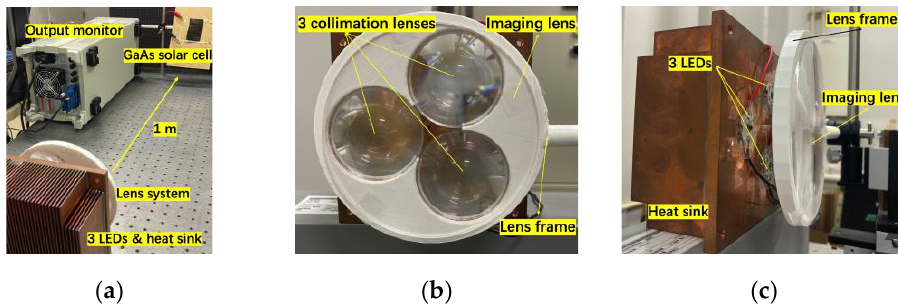
Figure 7. ( a ) Experiment setup; ( b ) lens combination; and ( c ) view from the side of the light source.